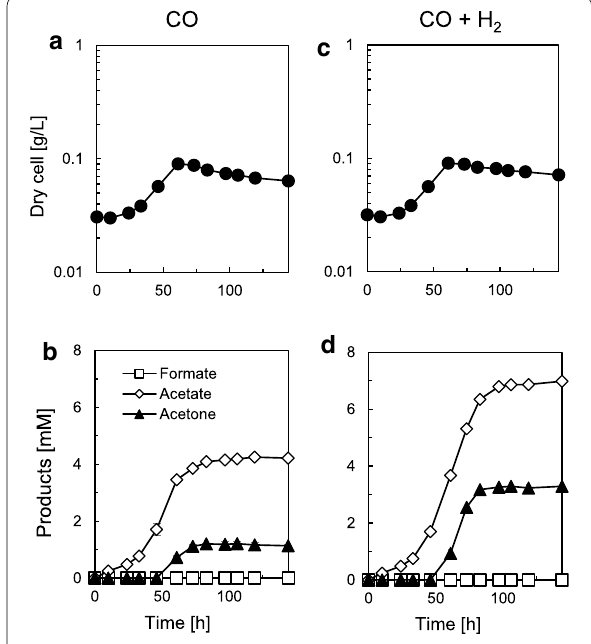
Fig. 4 Growth and metabolite profile of the pduL2::acetone strain in CO and CO–H 2 . a , c Dry cell weight according to the OD. b , d Excreted metabolites measured by HPLC. Profiles of CO ( a , b ) and CO–H 2 ( c , d ) are shown, respectively. The values shown are means of three biological replicates, and error bars represent the SD. Some error bars showing a small error range overlapped with symbols of data